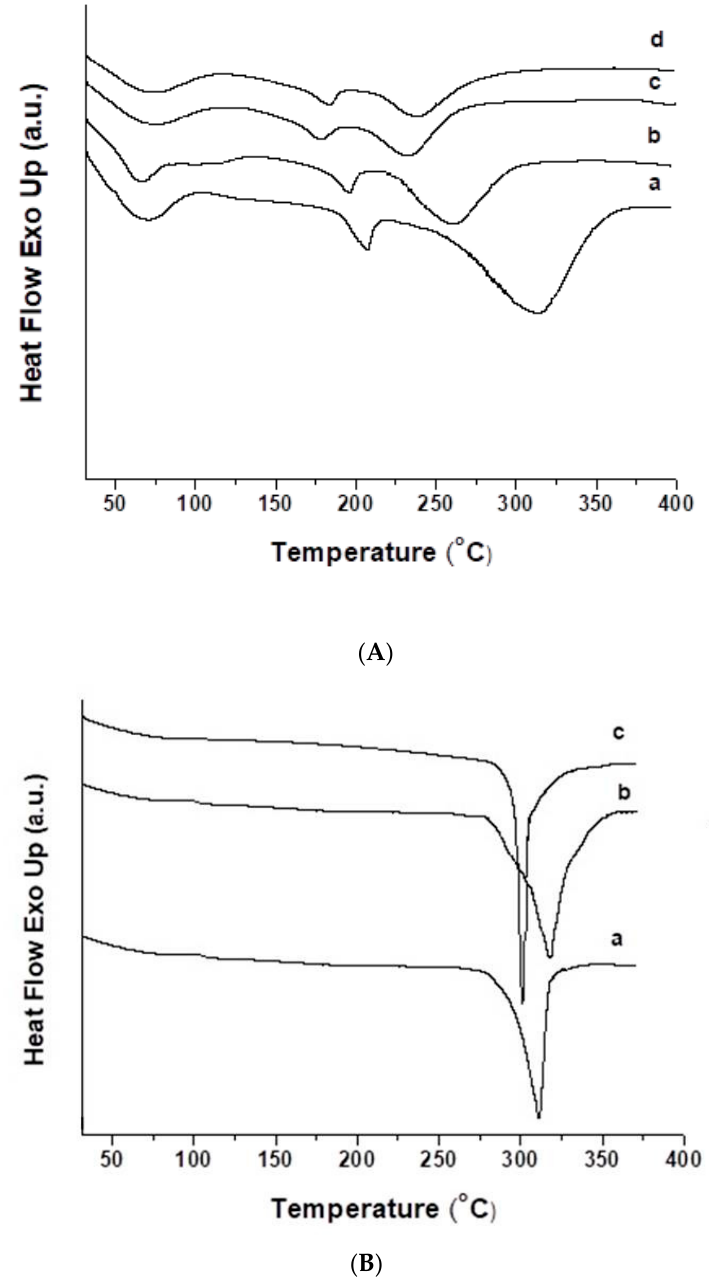
Figure 3. DSC thermograms of fibrous materials from ( A ): cr(PVA/Ch) (a), cr(PVA/Ch)/SQ (10 wt% SQ) (b), Cu 2+ complex of cr(PVA/Ch)/SQ (10 wt% SQ) (c) and Fe 3+ complex of cr(PVA/Ch)/SQ (10 wt% SQ) (d). For the sake of comparison, the DSC thermograms from ( B ): SQ (a), SQ.Cu 2+ (b) and SQ.Fe 3+ (c) are also presented.